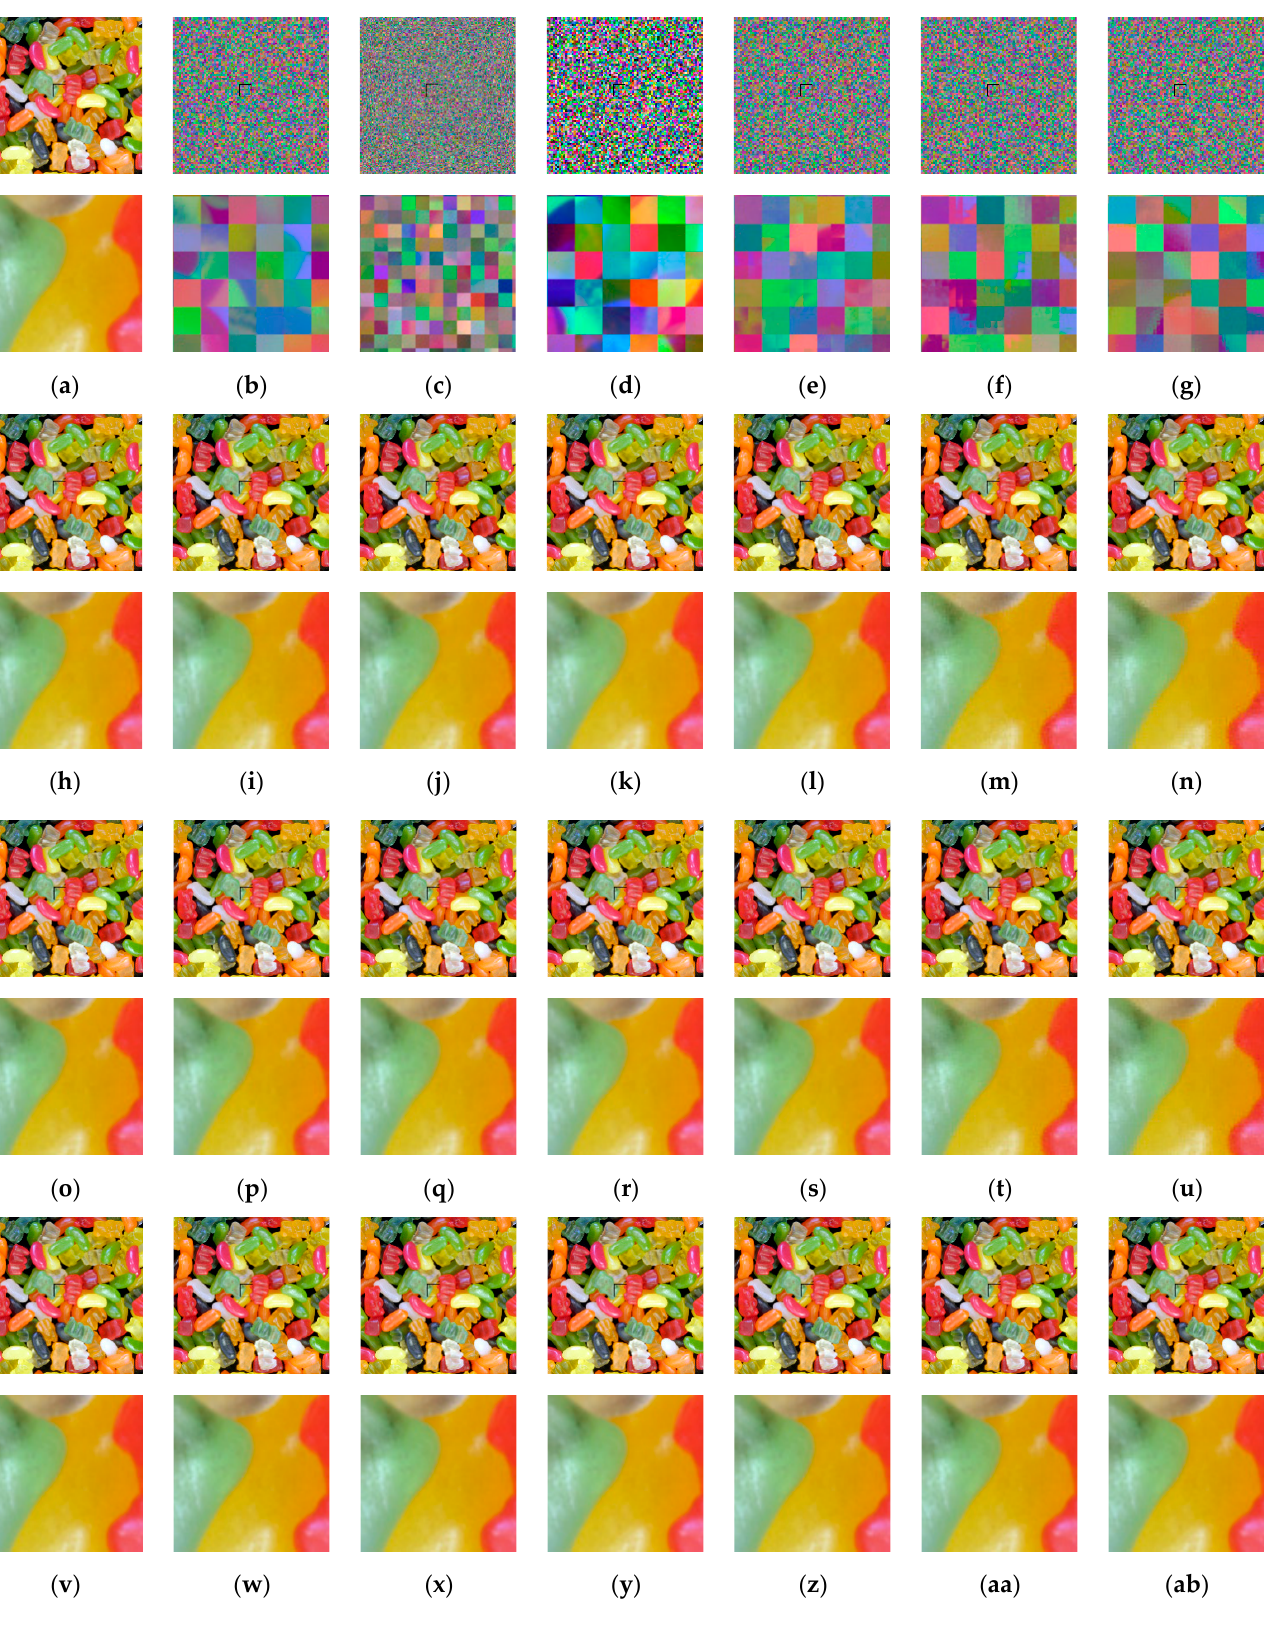
n ), 𝑞𝑓 = 85 in ( o – u ), and 𝑞𝑓 = 100 in ( v – ab ). For each image, the boxed region is zoomed in and